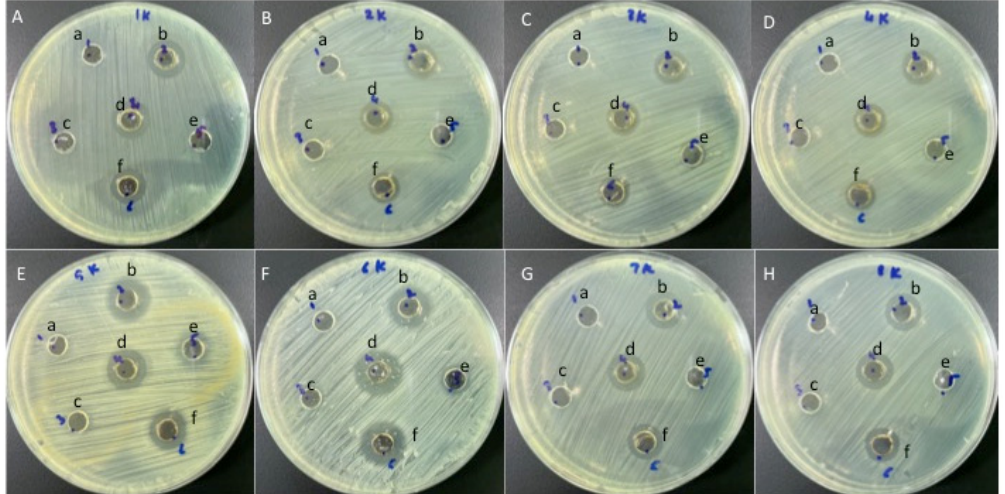
Figure 4. ( A – H ). Antibacterial properties are exhibited by the zones of inhibition produced by honey and honey with AgNPs (a = 20% honey, b = 20% honey with AgNPs, c = 40% honey, d = 40% honey with AgNPs, e = 80% honey, and f = 80% honey with AgNPs). ( A ) Pseudomonas aeruginosa ; ( B ) Escherichia coli ; ( C ) Klebsiella pneumoniae ; ( D ) Salmonella ; ( E ) Staphylococcus aureus ; ( F ) Staphylococcus saprophyticus ; ( G ) Streptococcus pyogenes ; ( H ) Enterococcus faecalis .